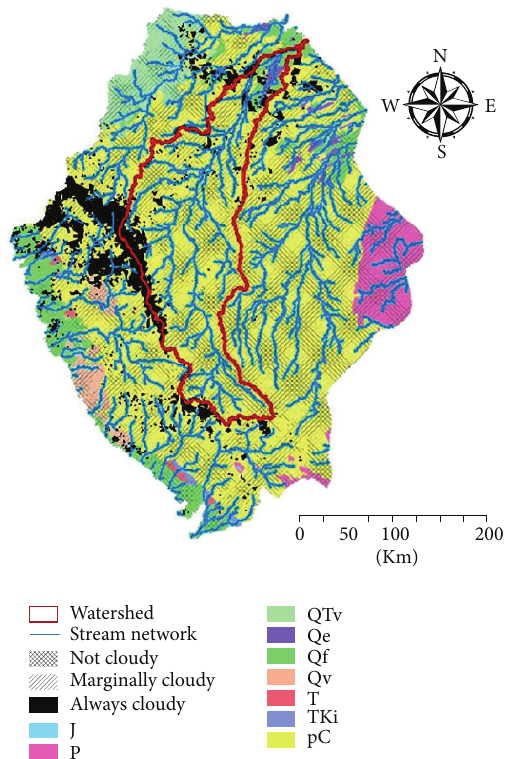
Figure 8: Stream network confined in the main watershed placed over the geology map of the southern part of KSA.